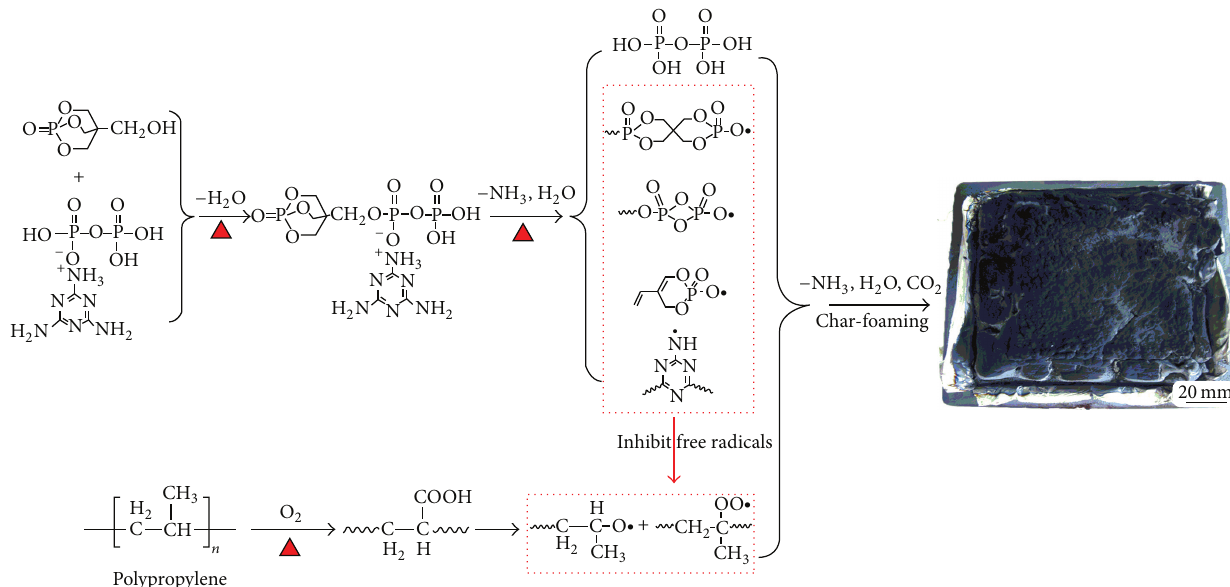
Figure 12: Possible flame-retardant and thermal degradation mechanism of MPP/PEPA for